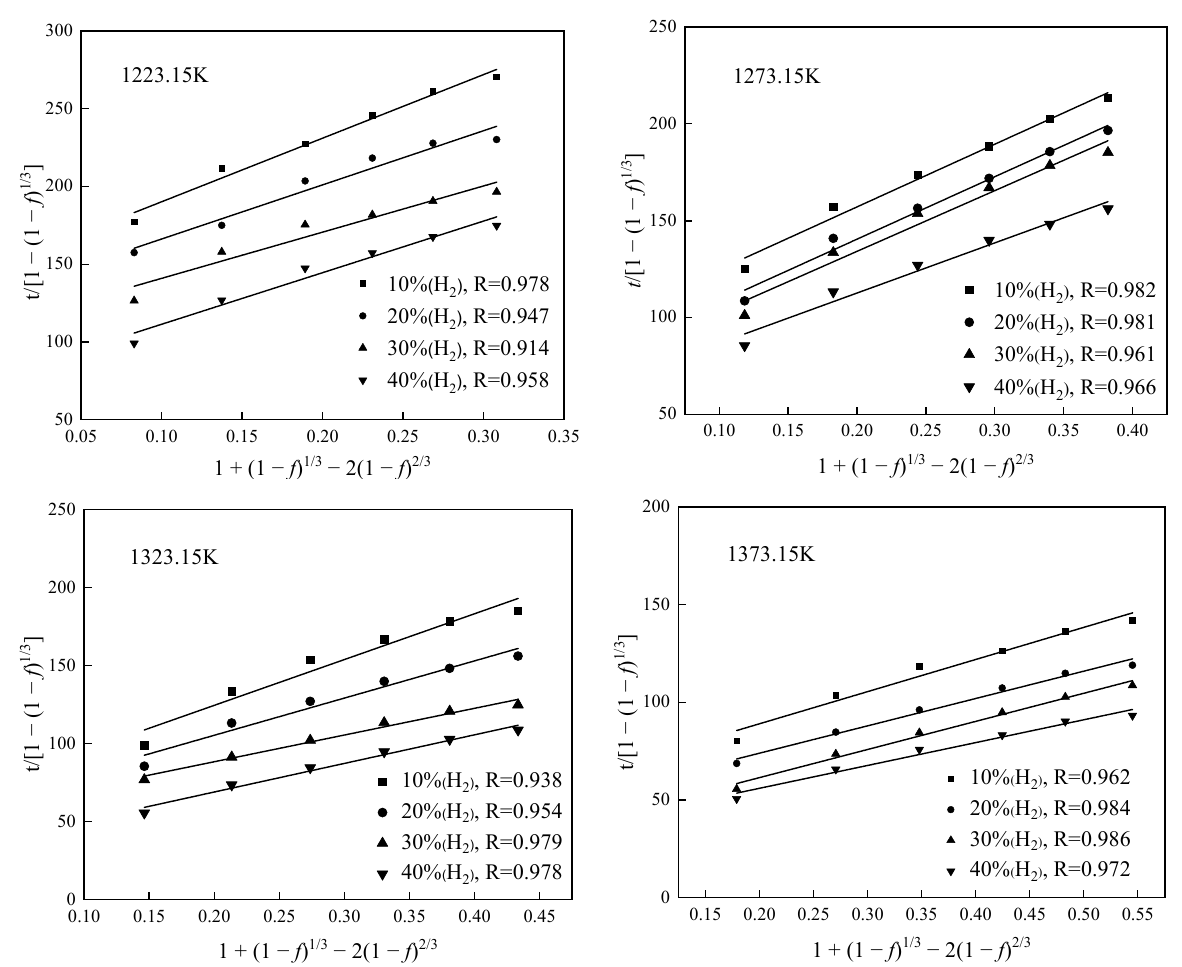
Figure 10. Comparison curve of the chemical-controlled reduction with the diffusion-controlled reduction.